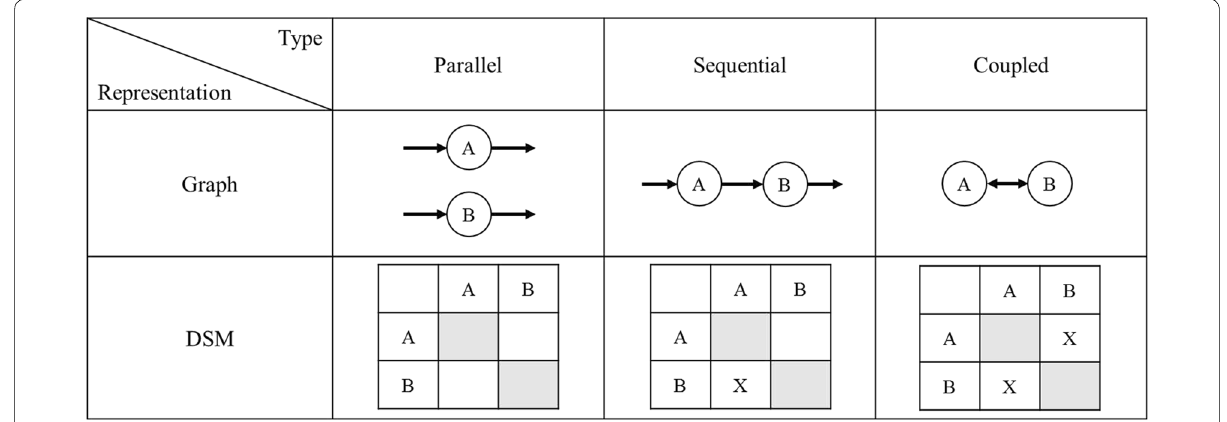
Fig. 1 Types of relationship between activities and their representations in the